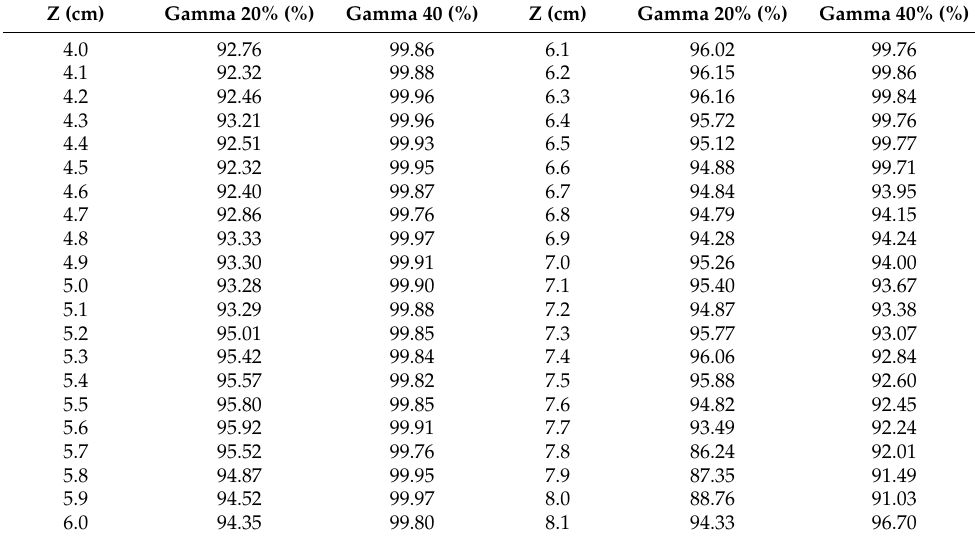
Table 1. Gamma’s pass rate for all slices in the junction region in the cylindrical vial. Cranial (Z = 4 cm) to spinal (Z = 8.1 cm)